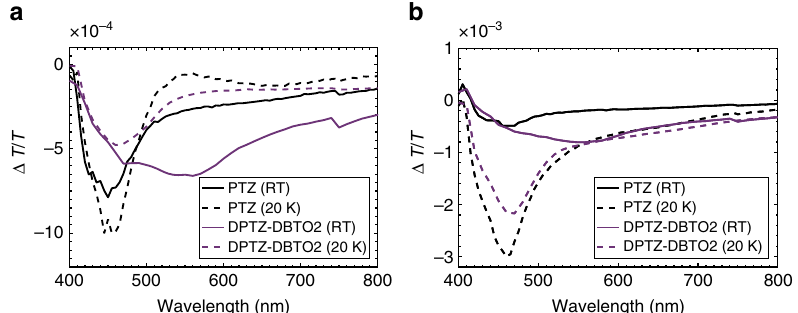
Figure 2 | The photoinduced absorption for phenothiazine and DPTZ-DBTO2 in zeonex. ( a ) The in-phase component of the PIA of phenothiazine (black) and DPTZ-DPTO2 (purple) in a zeonex host matrix, measured at room temperature (solid) and 20K (dashed). ( b ) The out-of-phase component of the PIA of the same